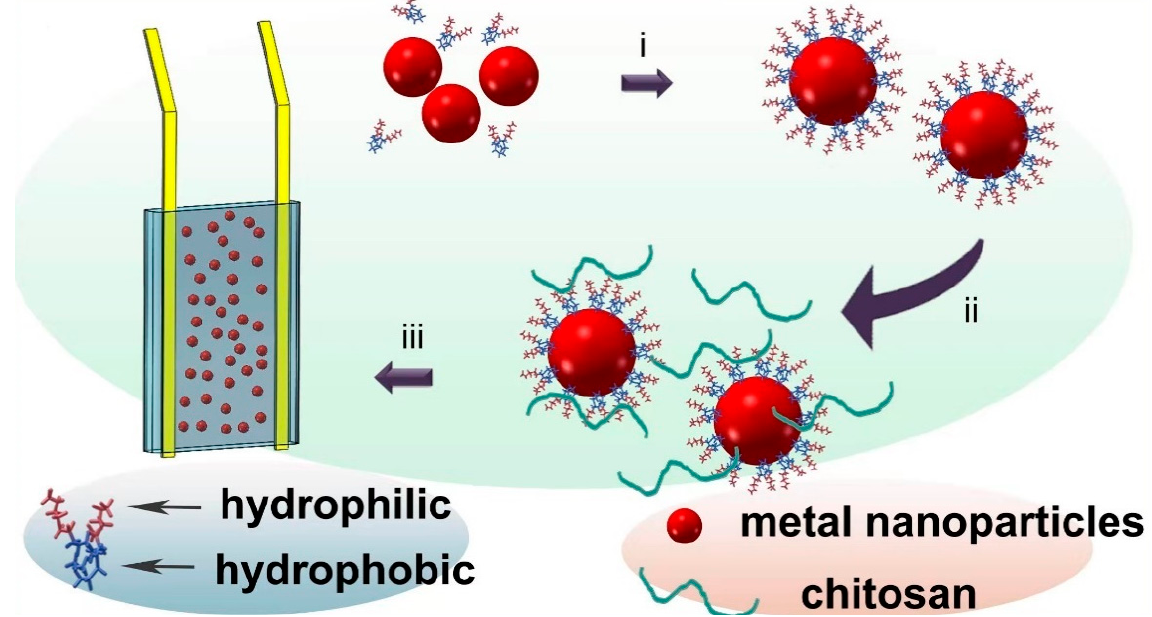
Figure 1. Schematic illustration of the coordinated electrodeposition of freestanding chitosan film. Step i: The surfactant and the NPs are mixed to ensure the coordination of the latter with the hydrophobic domains of the micelles. Step ii: addition of chitosan solution and stirring to trigger complexation of chitosan molecules with the hydrophilic portion of the pre-formed micelles. Step iii: electrodeposition.